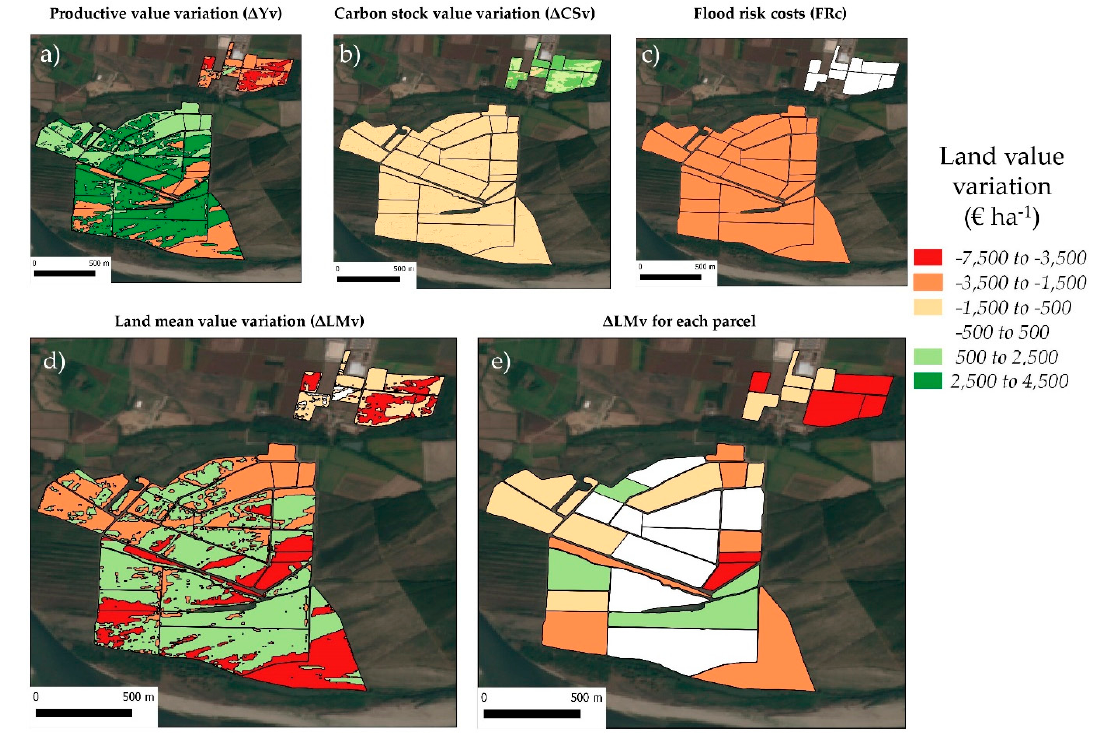
Figure 10. Maps of land value variation respect to the average of the area (37,000 € · ha − 1 ). The upper three maps ( a , b , and c ) show the spatial variation of the land value due to potential biomass production ( ∆ Yv), carbon stock ( ∆ CSv) and accounting of costs due to flood risk (FRc). Map ( d ) is the result of the adding of the ( a ), ( b ), and ( c ) maps, and shows the total variation of land mean value ( ∆ LMv). Map ( e ) shows the variation of land value calculated for each parcel.